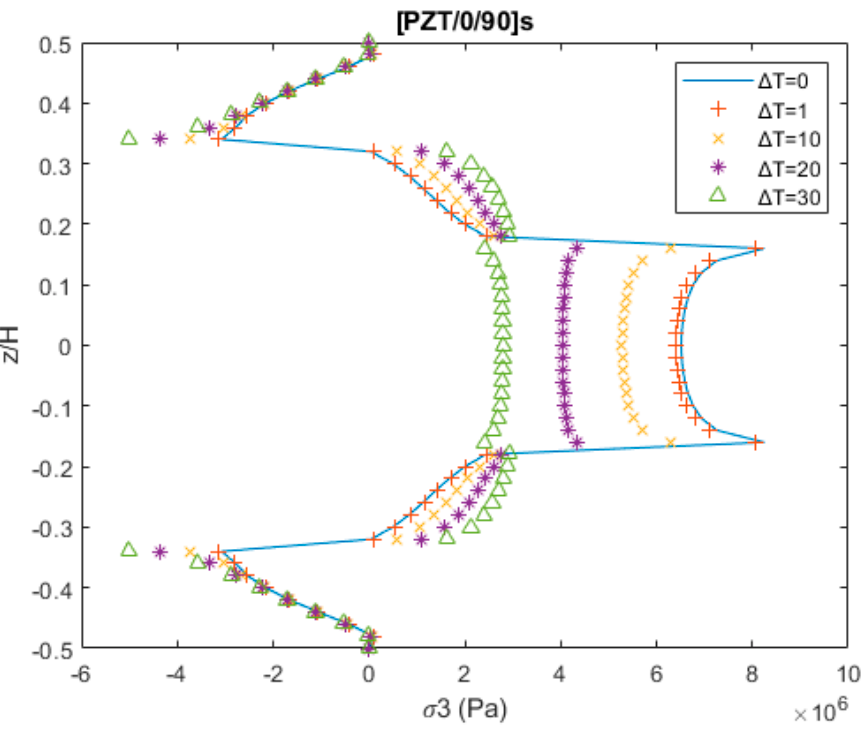
Figure 5. Free-edge σ 3 in [PZT/0/90] s laminate under the combined 0.1% uniaxial extension thermal loading and variable temperature loadings ( Δ T = (0, 1, 10, 20, and 30)). Similarly, Figure 6a,b show the ( σ 3 ) and ( σ 4 ) distribution through the in-plane direction at the PZT/0 interface. The magnitude of the peeling stresses decreased significantly with the increase in thermal loading: